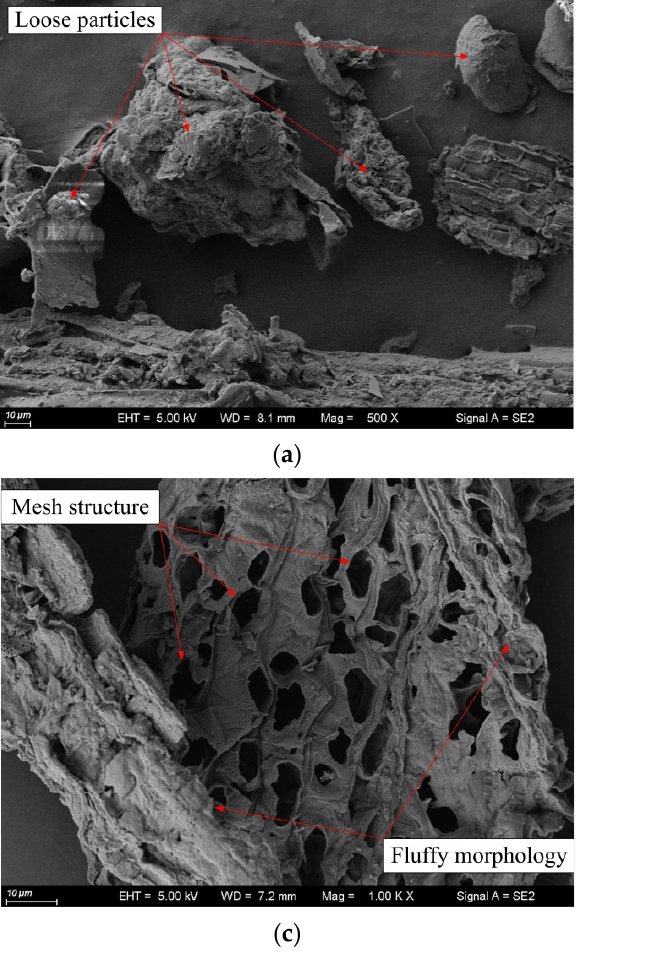
Figure 2. SEM images of the major materials mixed into substrates: ( a ) local substrate; ( b ) herbaceous peat; ( c ) sphagnum peat; ( d ) coir peat.